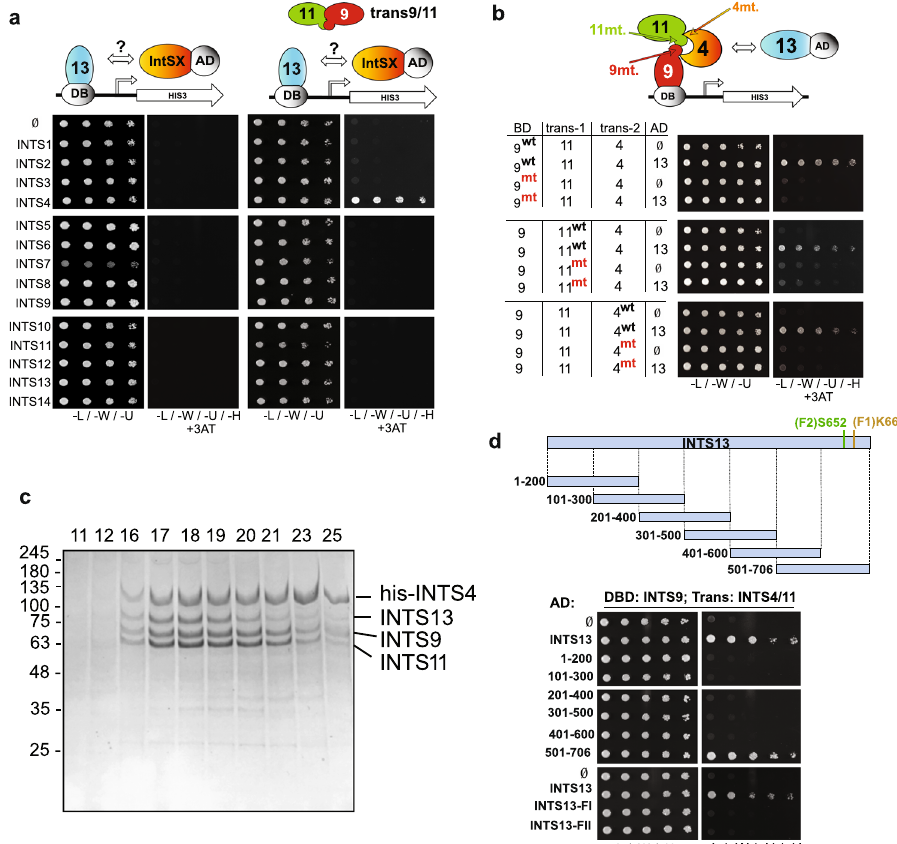
Fig. 3 | INTS13 associates with the INTS4/9/11 heterotrimer. a Yeast two hybrid screening for interactors of INTS13. Haploid strains of yeast expressing each indi- vidualIntegratorsubunitfusedtotheGal4activatingdomain(AD)werematedwith strainsexpressingINTS13fusedtotheDNAbindingdomain(BD).The fi rstandthird panels show mated yeast grown on selective media as a positive control (media lacking leucine, tryptophan, and uracil). The remaining panels are of yeast plated on restrictive media additionally lacking histidine to test for protein-protein interactions and with 3AT (3-amino-1,2,4-triazole) to test the strength of the interaction. No interaction was observed between INTS13 and any other individual subunit (second panel). When INTS9 and INTS11 were expressed in trans with INTS13, therewas a positive interaction with INTS4(fourth panel). b Point mutants of INTS4, INTS9, and INTS11knownto disrupttheir interactions wereusedinyeast two hybrid to demonstrate that the formation of the INTS4/9/11 heterotrimer is necessary for INTS13 association. General locations of the mutations are indicated